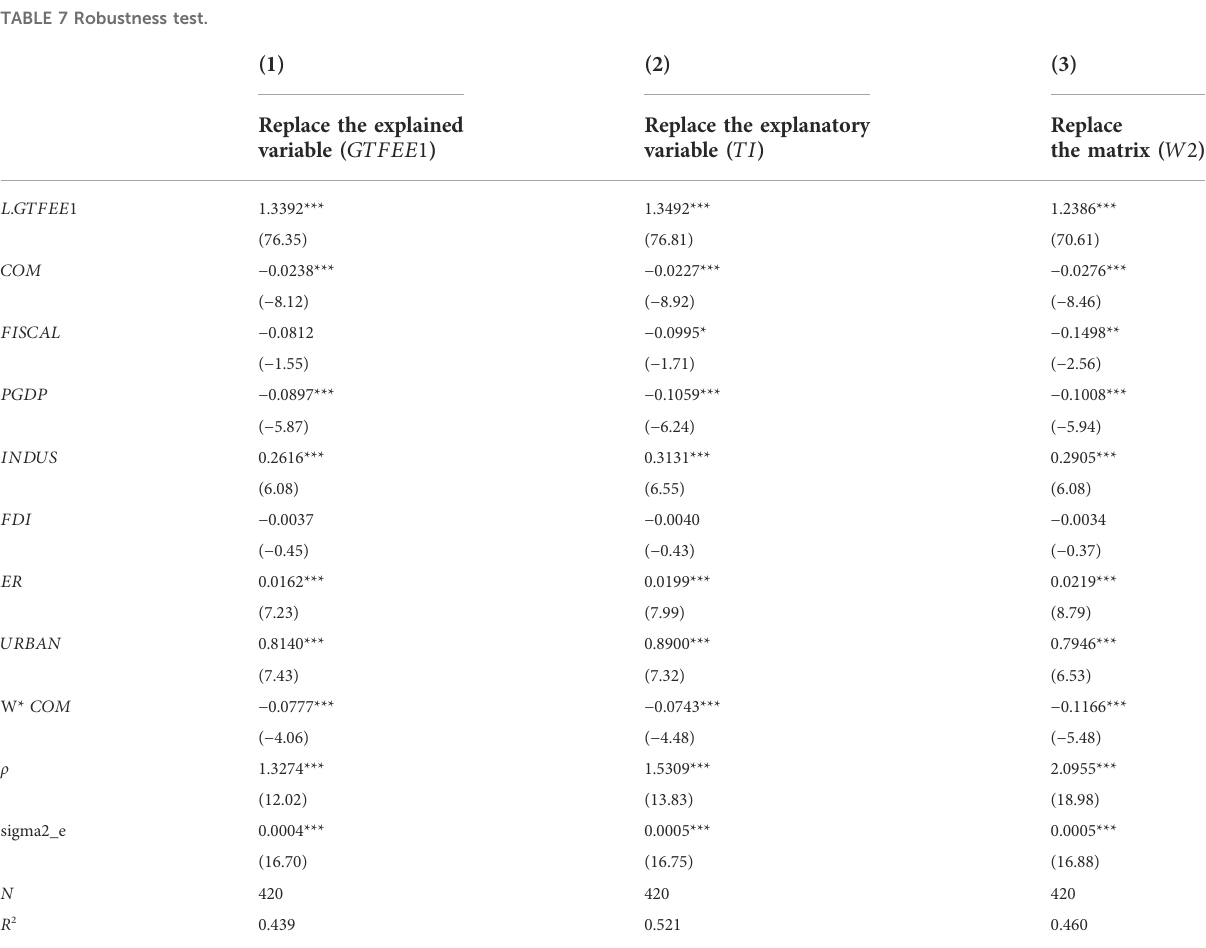
TABLE 7 Robustness